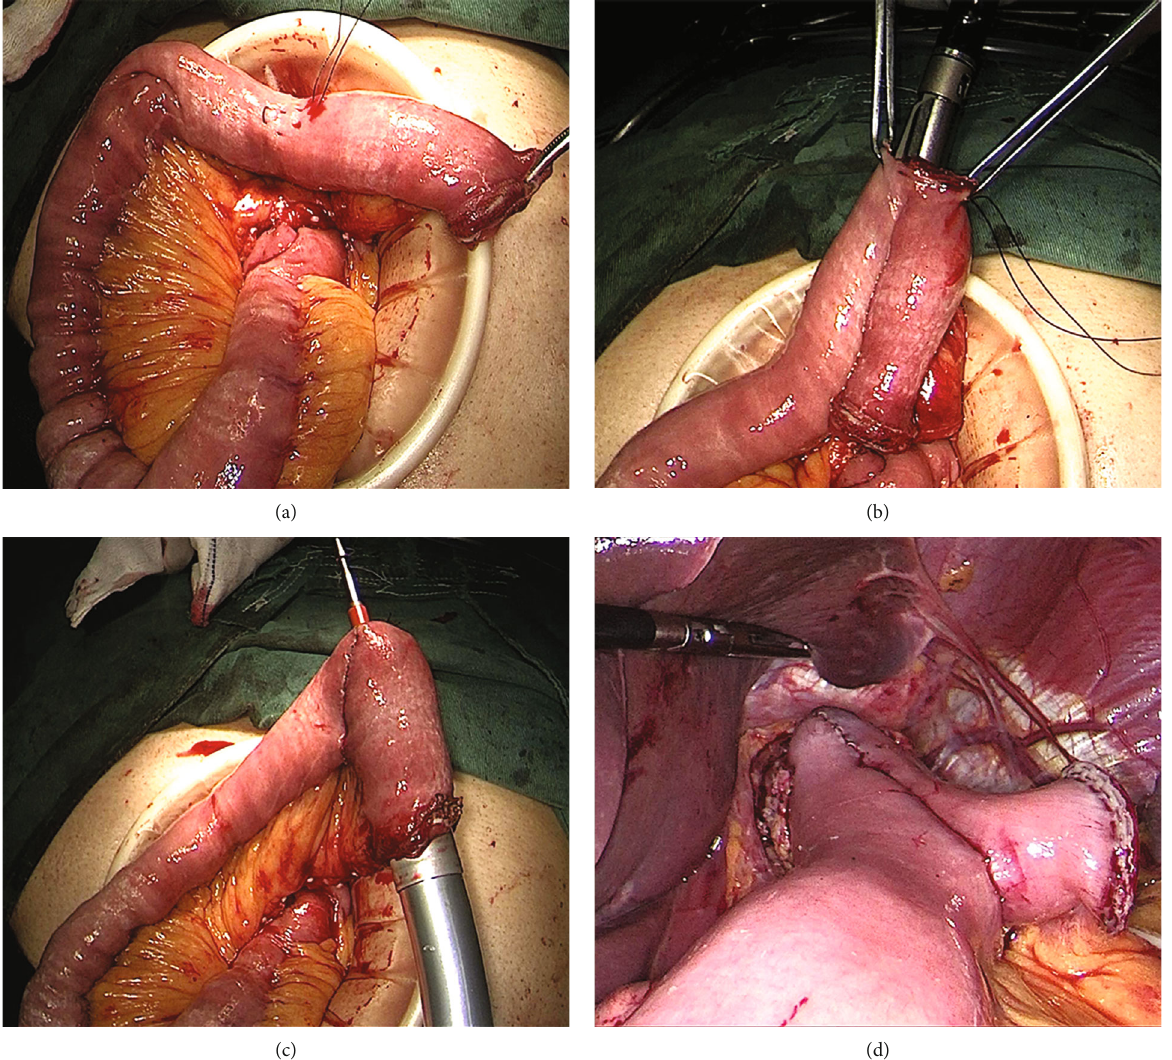
Figure 3: Surgical diagram of pant-shaped anastomosis. A purse-string suture was made on the antimesenteric edge 10cm away from the jejunal end, followed by an incision in its center (a). The two arms of a linear stapler were inserted into the a ff erent and e ff erent portion of the jejunum, respectively (b). A circular stapler was inserted into the jejunal pouch through the jejunal end, with the central rod puncturing through the antimesenteric incision (c). After the EJS was fi nished, the remnant entry was closed using a linear stapler